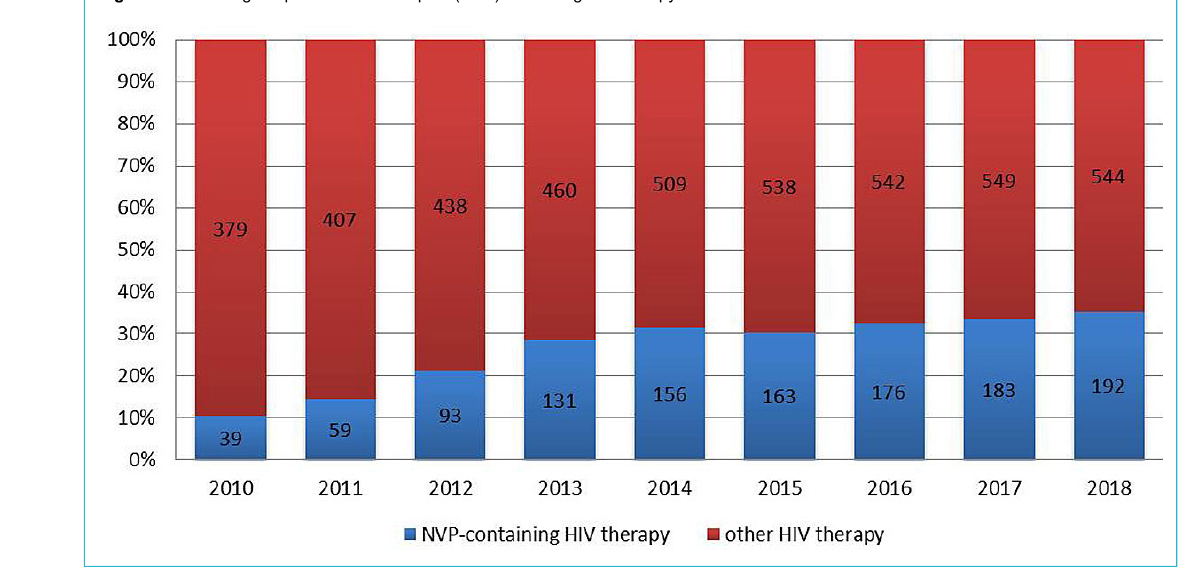
Figure 1: Percentage of patients on nevirapine (NVP)-containing HIV